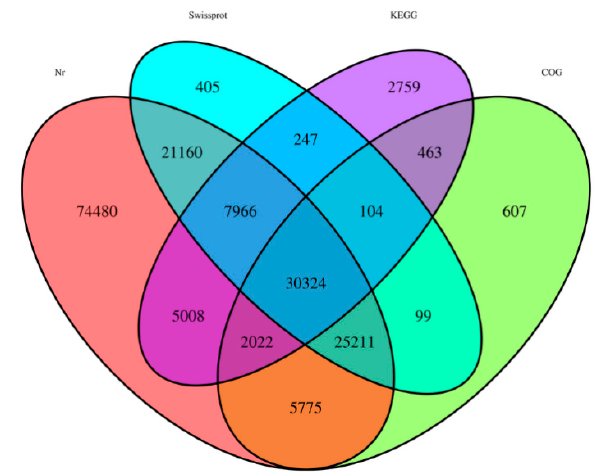
Figure 2. Outcome of the homology search of T. monococcum UniGenes.